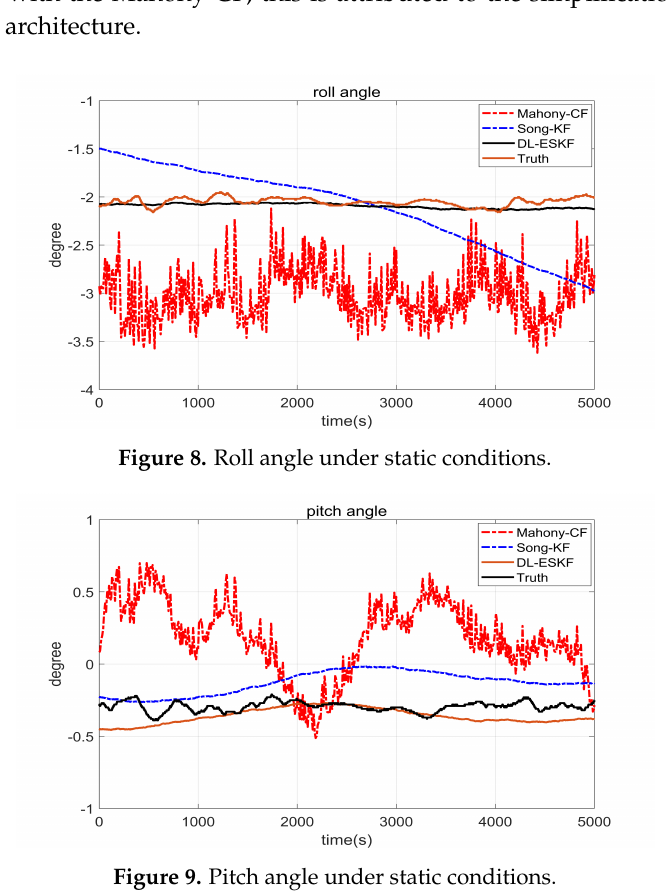
Figure 9. Pitch angle under static